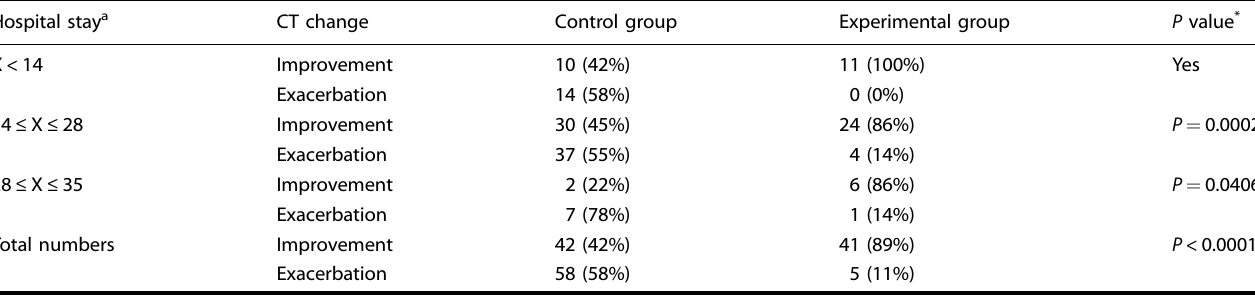
Table 3. Comparison of the effect of hymecromone on pulmonary lesions in COVID-19 patients classi fi ed by different hospitalization Hospital stay a CT change Control group Experimental group P value *